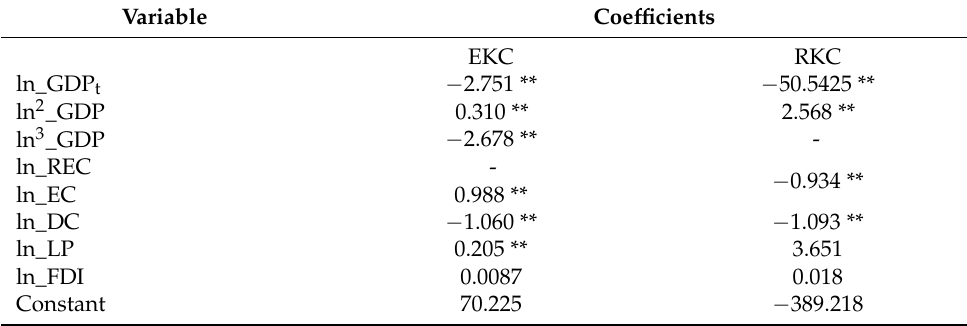
Table 8. Pesaran common correlated effects estimators in extended ERK and RKC for V4 and Baltic countries 1 . Variable